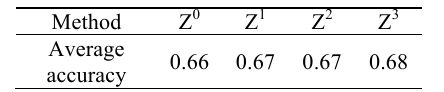
Table 8. Average classification accuracies for different data normalization methods.